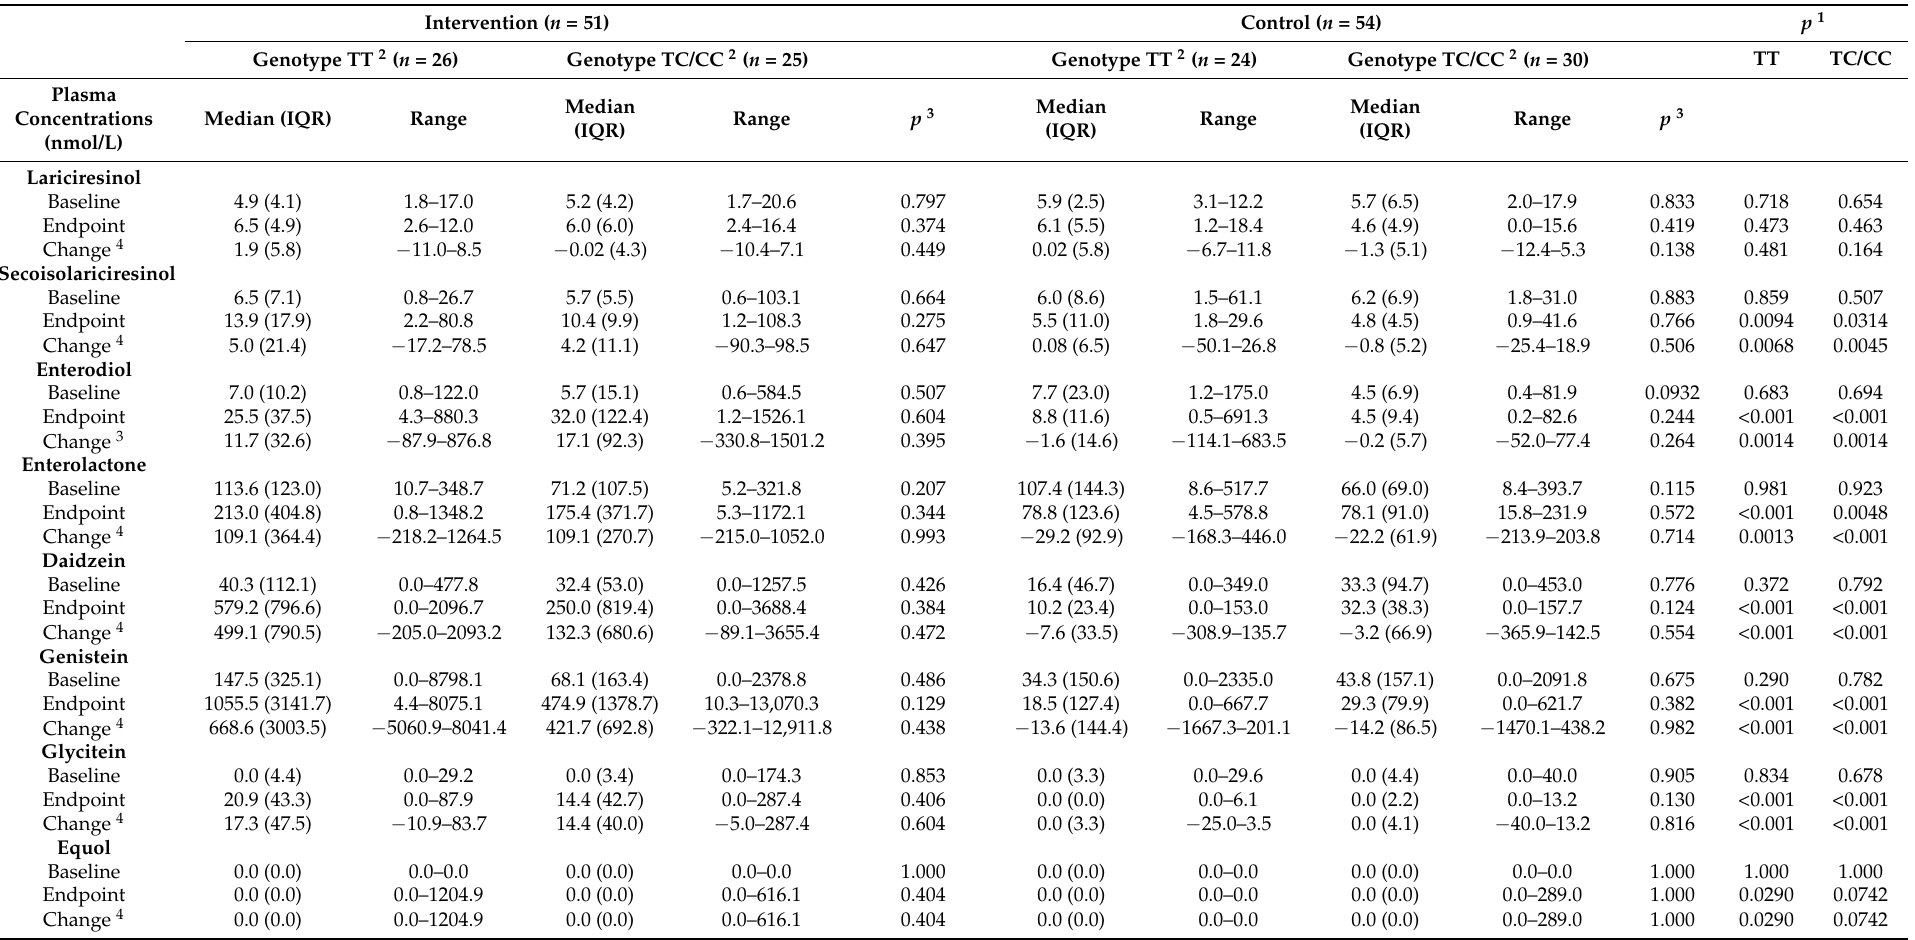
Table 4. Plasma concentrations of phytoestrogens in the intervention and control groups in patients with prostate cancer, stratified by the genotype of estrogen receptor